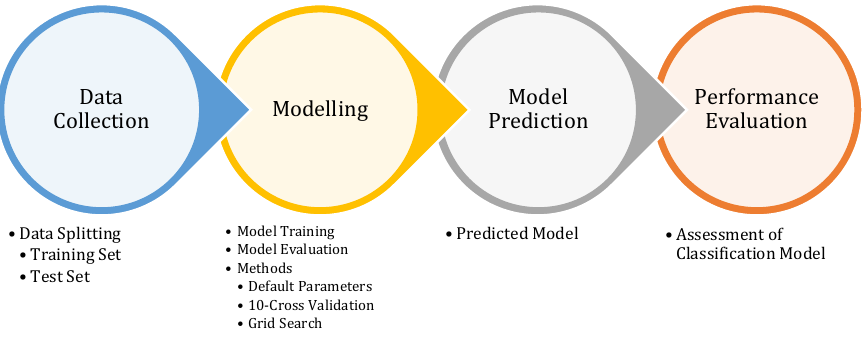
Figure 1. Research Figure 1. Research Methodology .